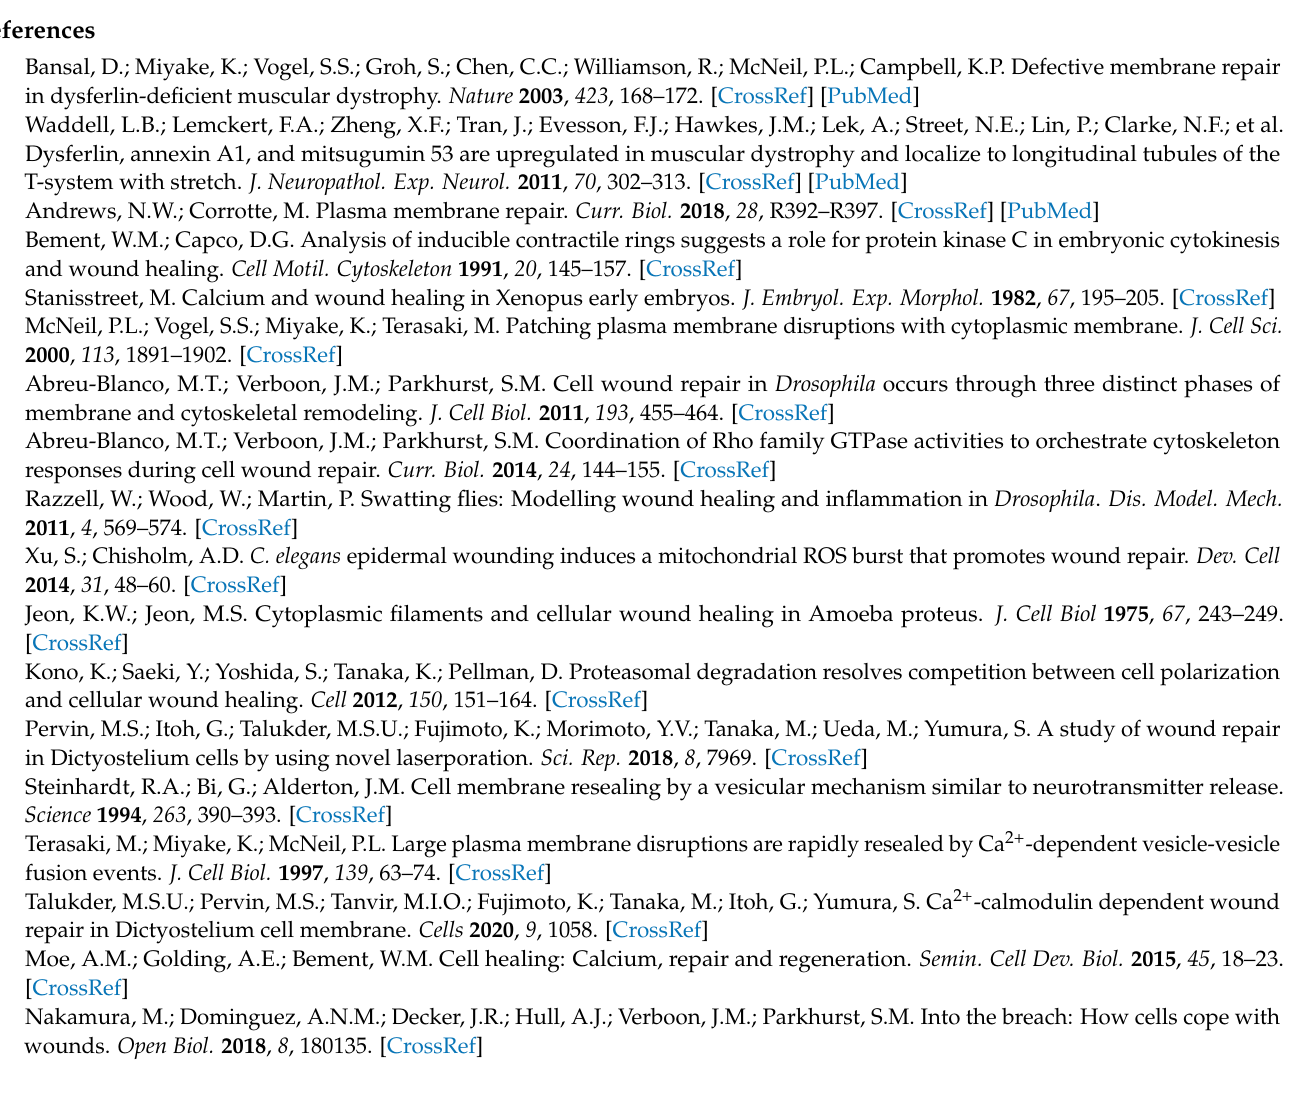
Figure S2: Time courses of fluorescence intensities of examined GFP-tagged protein; Figure S3: Time courses of fluorescence intensities of GFP-lifeact in ARP-null or wild-type cells in the presence of inhibitors; Figure S4: Time courses of fluorescence intensities of GFP-lifeact in signal-related or other protein-null or wild-type cells in the presence of inhibitors; Table S1: Descriptions of examined proteins and their roles in wound